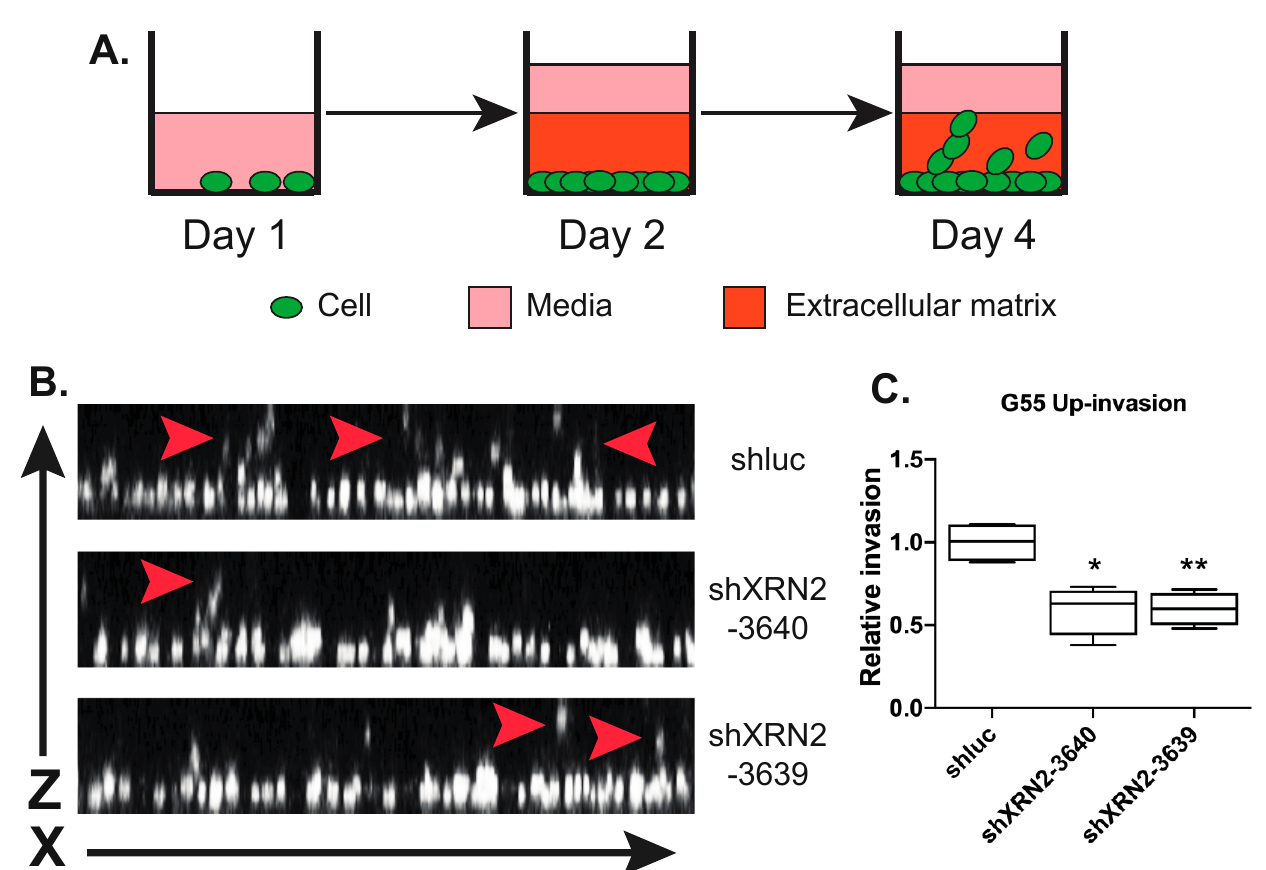
Figure 3. XRN2 is required for invasion through a matrix. ( A ) Diagram of inverted vertical invasion. Day 1—cells are plated at near confluent levels. Day 2—extracellular matrix is applied to the confluent cells. Day 4—cultures are fixed, stained, and imaged for invasion analysis. ( B ) Representative ZX image of invading G55 cells (white). Red arrows denote invading cells. ( C ) Quantification of up-invasion of G55 cells with the listed shRNAs. * = p -value ≤ 0.05, ** = p -value ≤ 0.01. The Students t -test was used for statistical analysis.